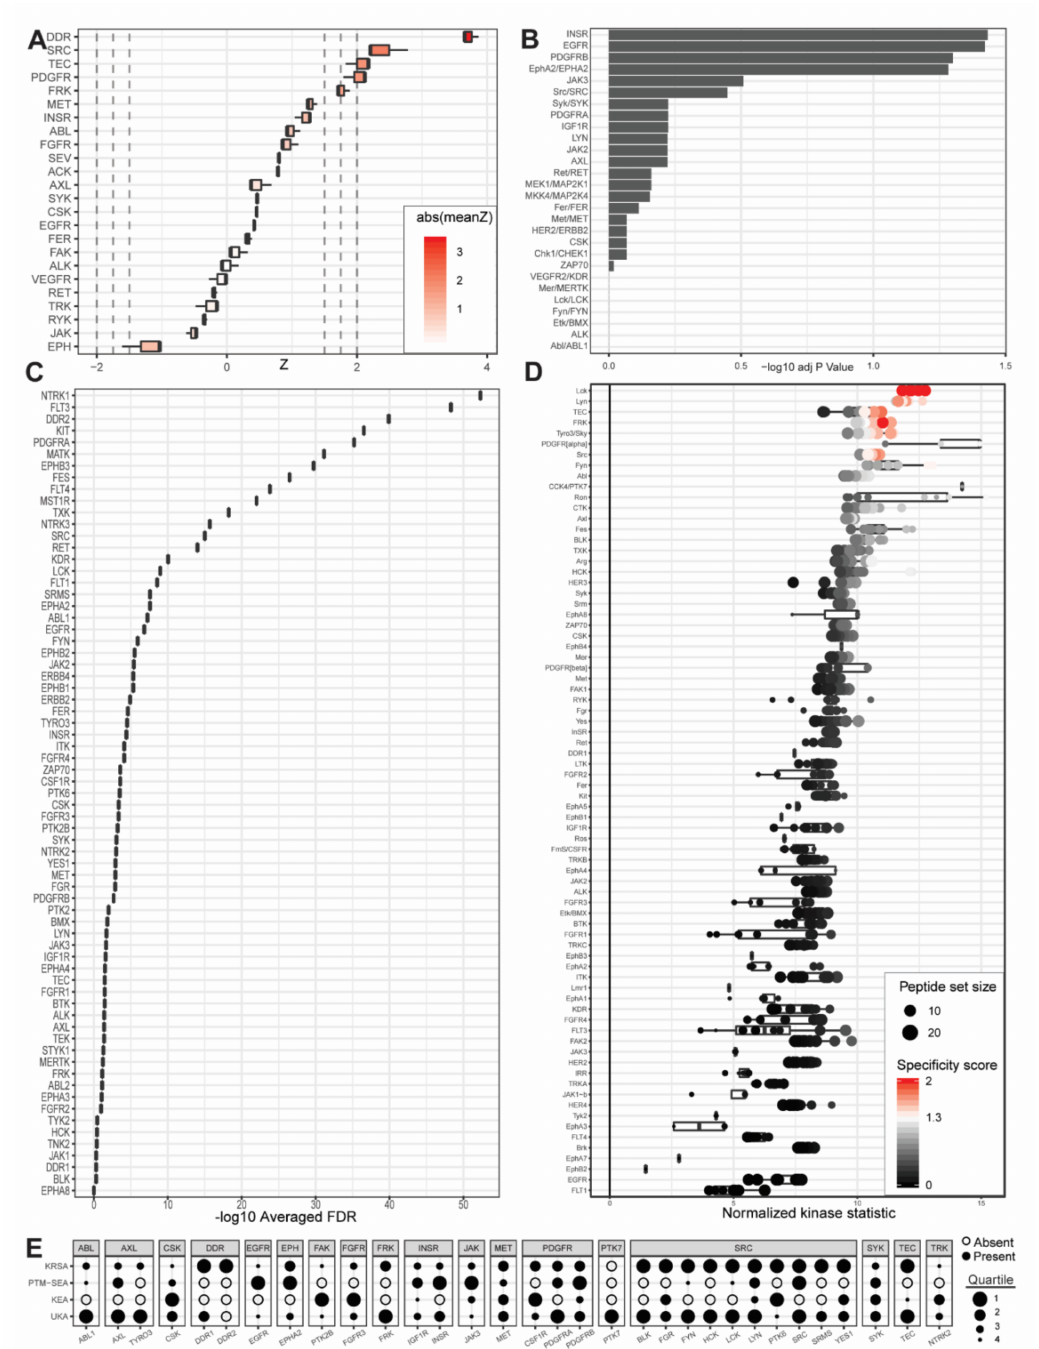
Figure 3. Outputs from upstream kinase identification pipelines for the patient-derived PDCL15 PDAC cell line compared to patient-derived wild-type pancreatic tissue. ( A ) Kinome Random Sampling Analyzer (KRSA); ( B ) Post-Translational Modification Signature Enrichment Analysis (PTM-SEA); ( C ) Kinase Enrichment Analysis Version 3 (KEA3); ( D ) Upstream Kinase Analysis (UKA). ( E ) Quartile summary. A more detailed figure legend can be found in Appendix